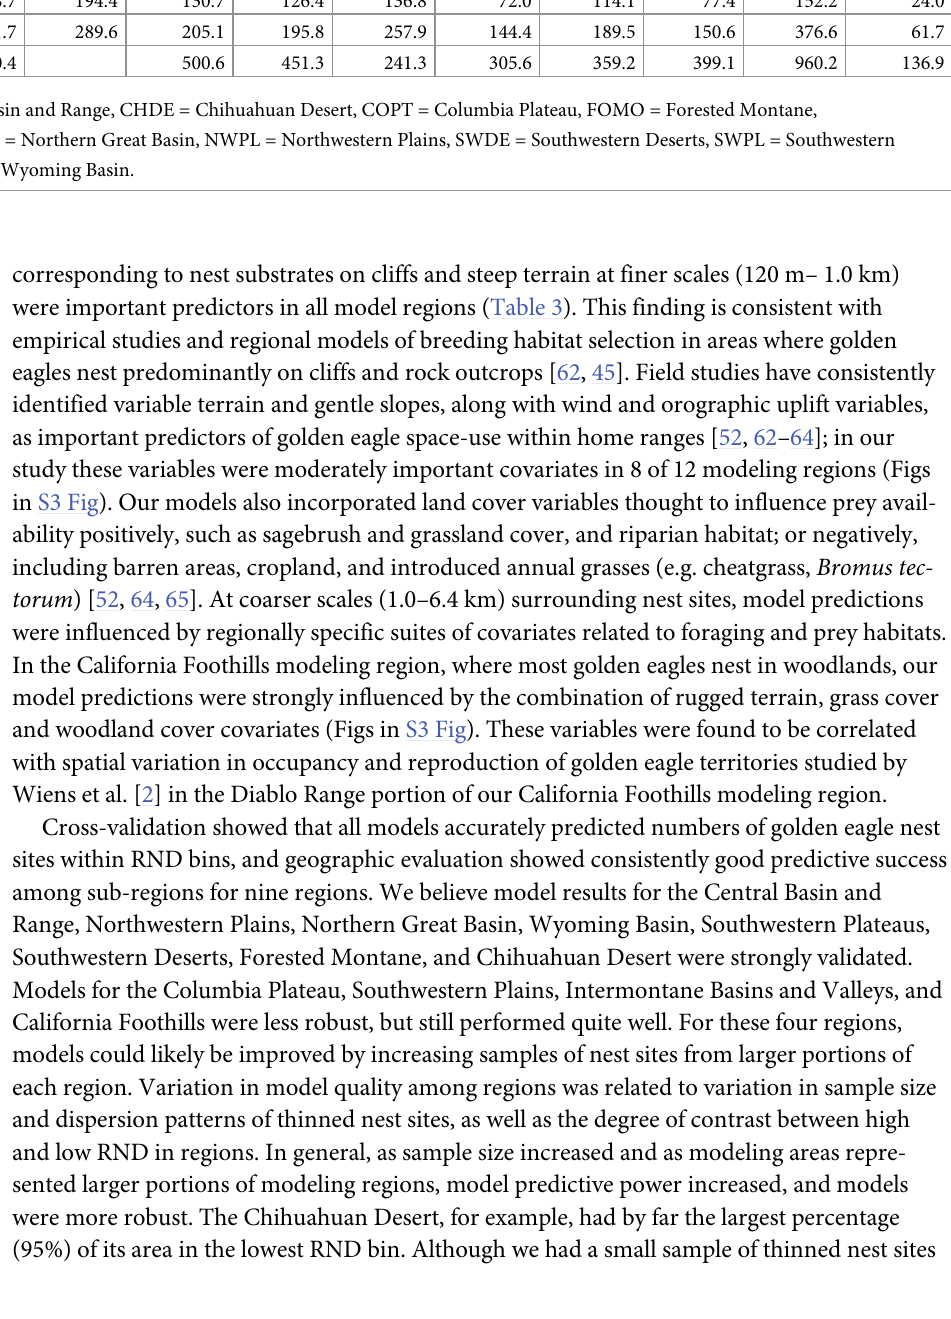
CAFO = California Foothills, CBRA = Central Basin and Range, CHDE = Chihuahuan Desert, COPT = Columbia Plateau, FOMO = Forested Montane, IMBV = Intermontane Basins and Valleys, NGRB = Northern Great Basin, NWPL = Northwestern Plains, SWDE = Southwestern Deserts, SWPL = Southwestern Plains, SWPT = Southwestern Plateaus, WYBA = Wyoming